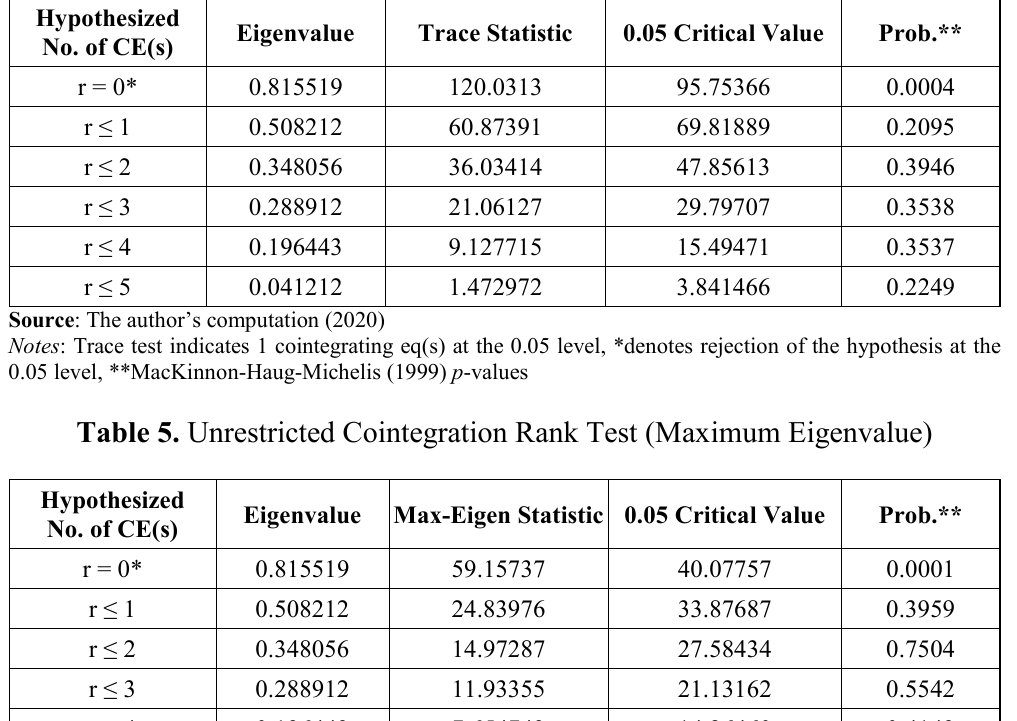
Table 4. Unrestricted Cointegration Rank Test (Trace) Hypothesized